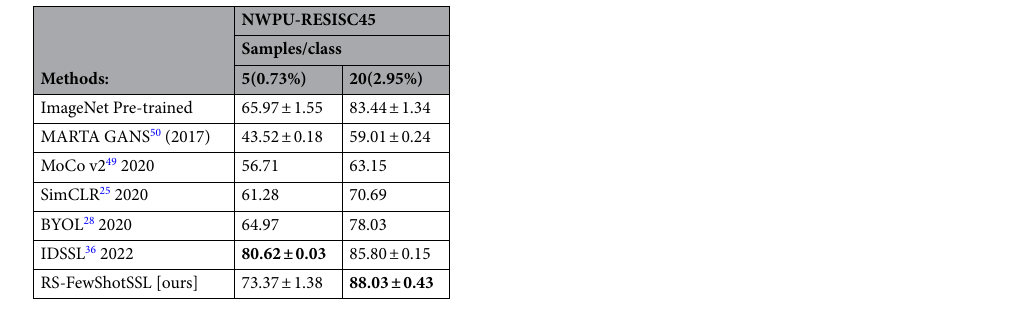
Table 5. RS-FewShotSSL results for the NWPU-RESISC45 and comparison to state-of-the-art methods. Significant values are in bold.